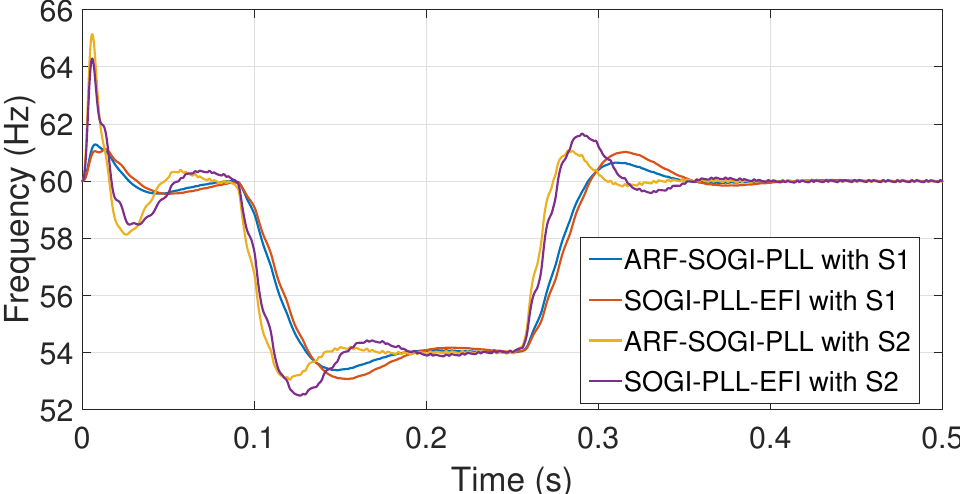
Figure 21. Frequency measured following − 6 Hz deviation during 0.166 s, and its recovery, using a high bandwidth and a typical bandwidth in the PLLs control